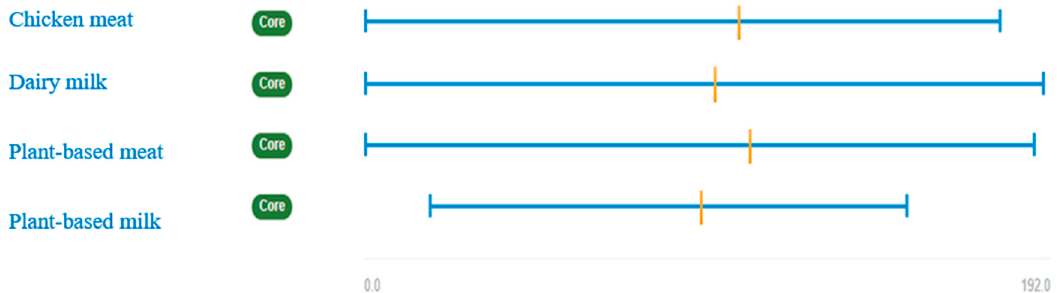
Figure 3. Uncertainty (all stakeholder’ views). The orange cross-line represents the average degree of uncertainty. The blue line refers to extreme values (the left and right ends show the largest and lowest degrees of uncertainty).